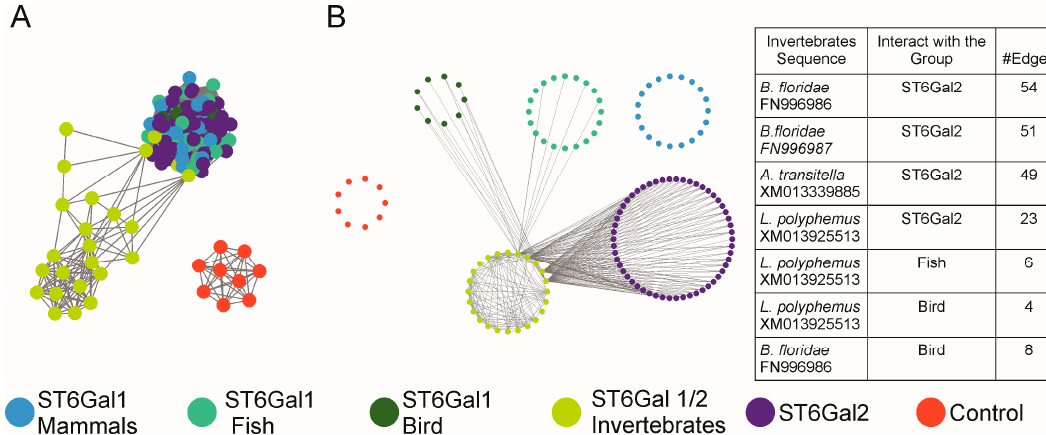
Figure 6. Sequence similarity network of ST6Gal sequences. The Figure represents ST sequences as nodes (circles) and all pairwise sequence relationships (alignments) better than a BLAST E -value threshold of 1E-83 as edges (lines). The network is composed by 126 ST6Gal sequences and 9 ST3Gal sequences as control group (red circles). ( A ) The network is visualized using a Force Direct layout, where the length of the edges is inversely proportional to the sequence similarity. Sequences belonging to Invertebrates form a separate group from all ST6Gal sequences, pointing out the dissimilarity with ST6Gal I and ST6Gal II sequences. To better visualize the relationships of invertebrates sequences, we show only the edges that involve the Invertebrate sequences; In panel ( B ) sequences are clustered by groups without using edges information (the edges are not proportional to sequence similarity). The network shows that seven invertebrate sequences are related with sequences of ST6Gal2 and ST6Gal1 of the Bird and Fish groups. The names of the invertebrate sequences related to other groups and the number of edges are shown in the table. It is important to note that the Invertebrate sequences do not show relationships with the mammalian ST6Gal1 sequences at this threshold.